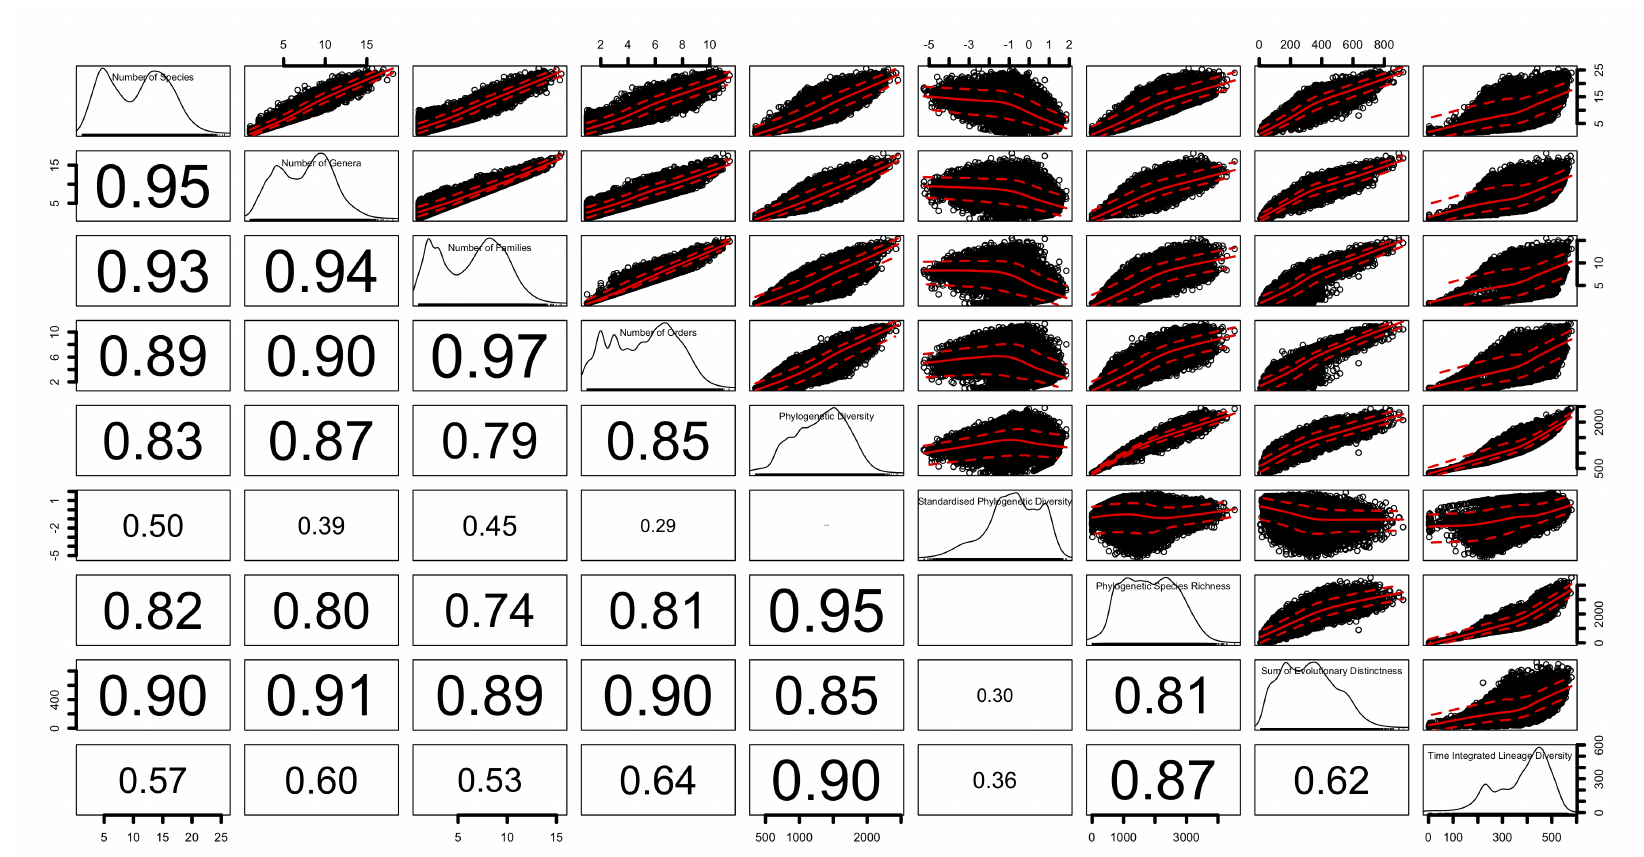
Figure 6. Pairwise relationships between lineage diversity metrics, with Pearson’s correlation coefficient given on the lower half of the matrix. The solid red line represents a loess, moving average regression and the dashed red lines represent the conditional variability over the range of the x-axis. The diagonal gives probability density plots for each